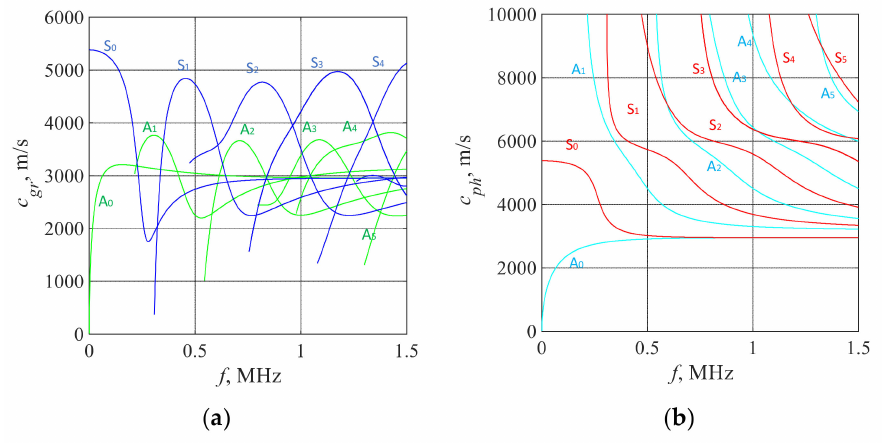
Figure 1. Dispersion curves in a 9 mm SteelAlloy1020 plate: ( a ) group velocity; ( b ) phase